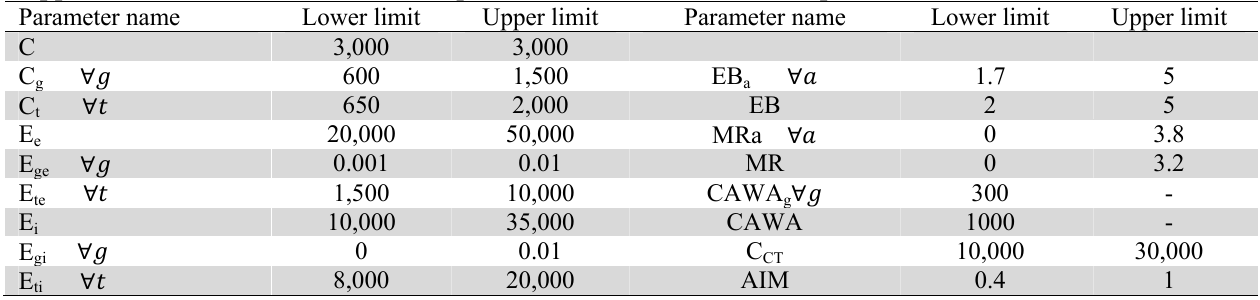
Upper and lower limits for different parameters of numerical